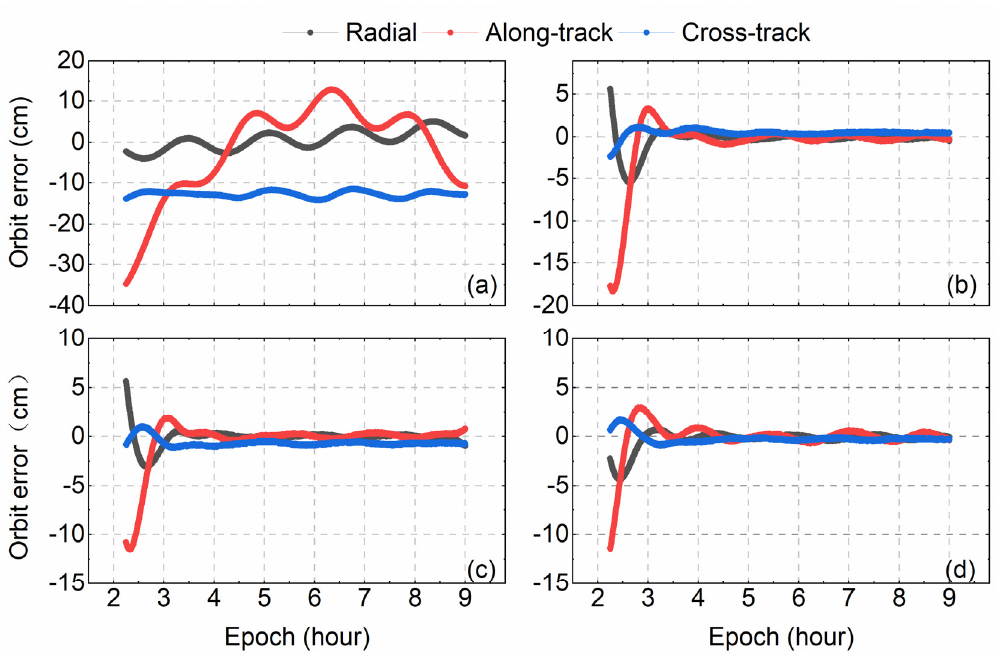
Figure 13. The error of Luojia-1A satellite orbit with different piecewise constant acceleration parameter strategies. ( a ) Without piecewise constant accelerations. ( b ) 30 min interval. ( c ) 15 min interval. ( d ) 6 min interval.